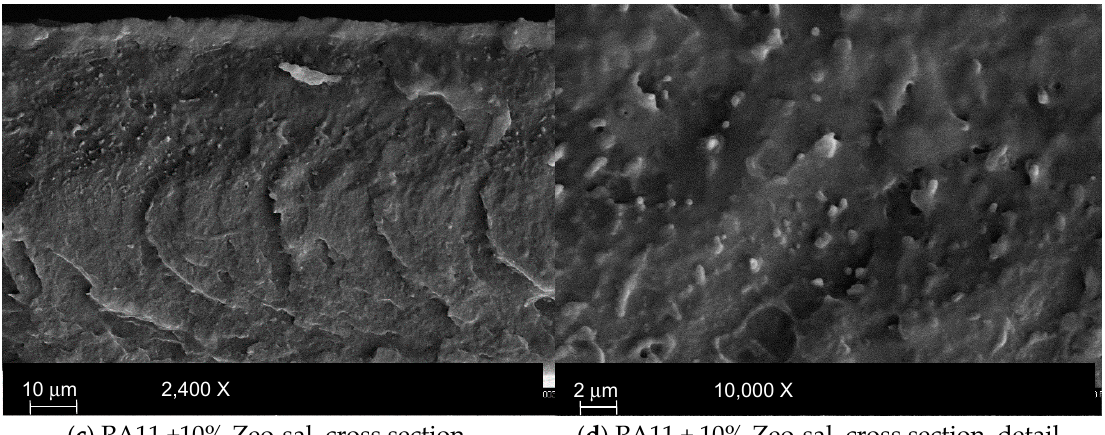
Figure 3. SEM images of the films. ( a ) surface of the PA11 film PA11 + 3% Zeo-sal; ( b ) surface of the PA11 + 10% Zeo-sal film; ( c ) cross section of the film PA11+ 10% Zeo-sal film; ( d ) detail of the cross section of the film PA11+ 10% Zeo-sal film di PA11 + 10%.